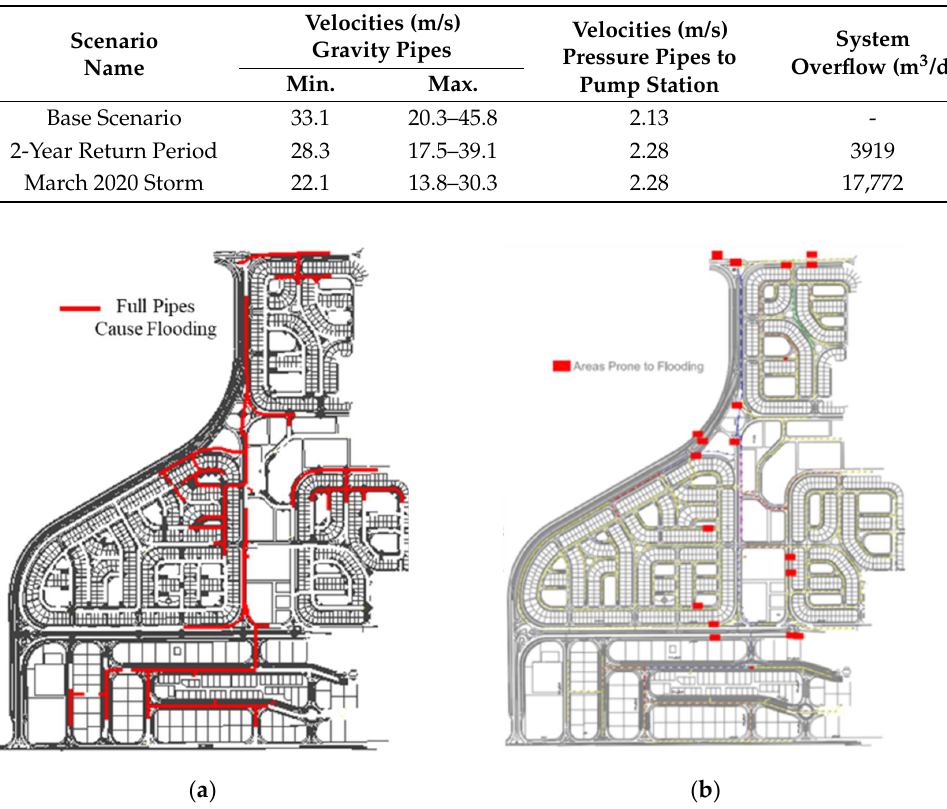
Figure 13. ( a ) Inundation areas simulated during March 2020 storm; ( b ) inundation areas recorded by local authorities during rainstorms. by local authorities during